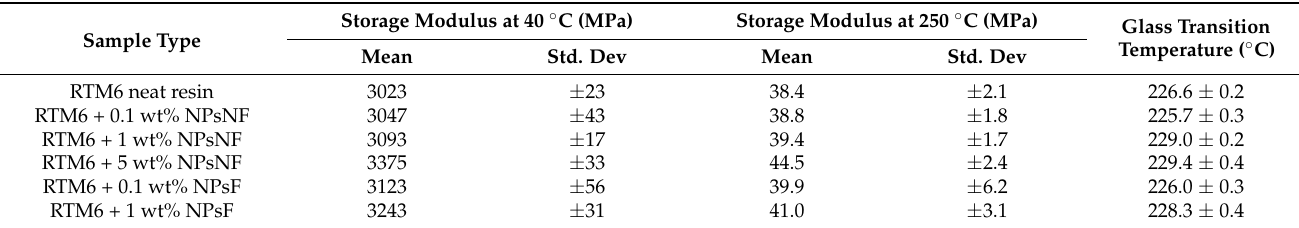
Figure 6. DMA curves of the silica/RTM6 epoxy nanocomposites compared to the neat RTM6 epoxy: ( a ) NPsNF and ( b ) NPsF filled nanocomposites. Table 3. Dynamical mechanical analysis